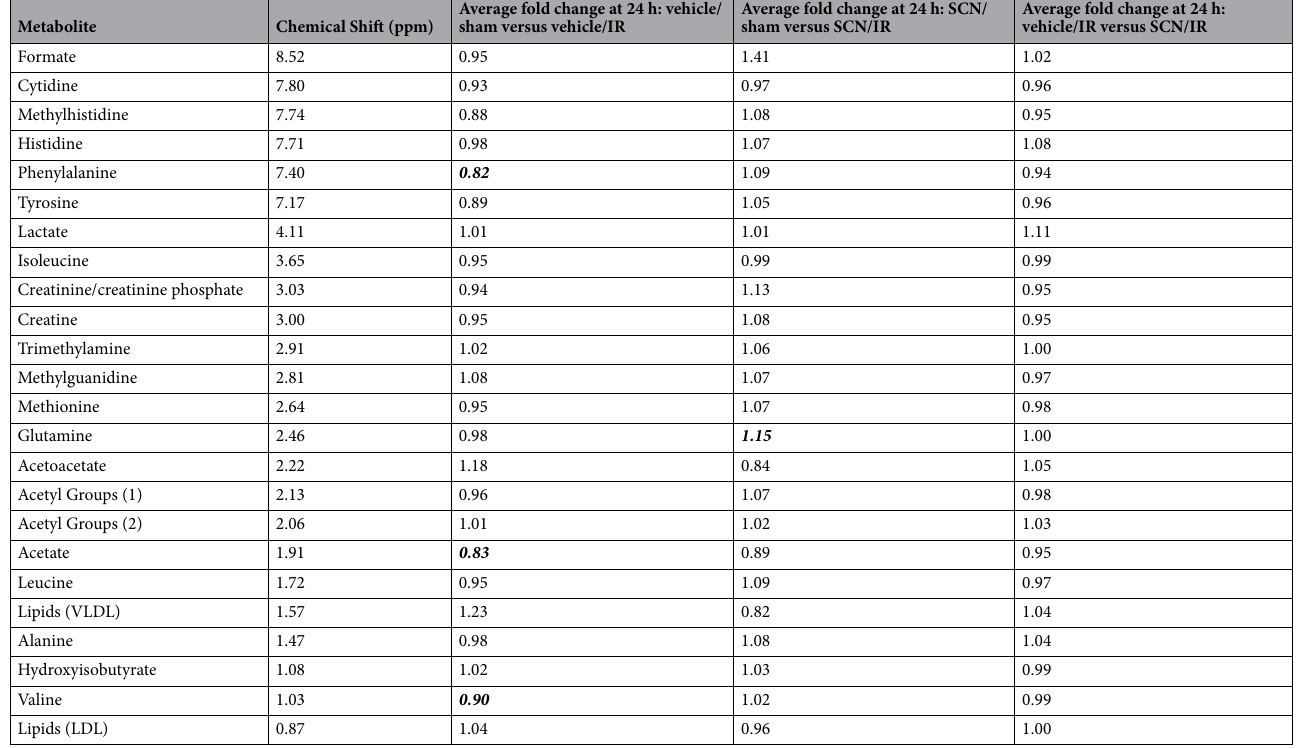
Table 1. Concentrations of major endogenous metabolites quantified in rat serum by 1 H-NMR, and their change in expression in vehicle/IR and SCN − -supplemented/IR rats at 24 h following surgery. Significant differences between groups were determined by two-tailed t tests with Welch’s correction, and are indicated in bold and